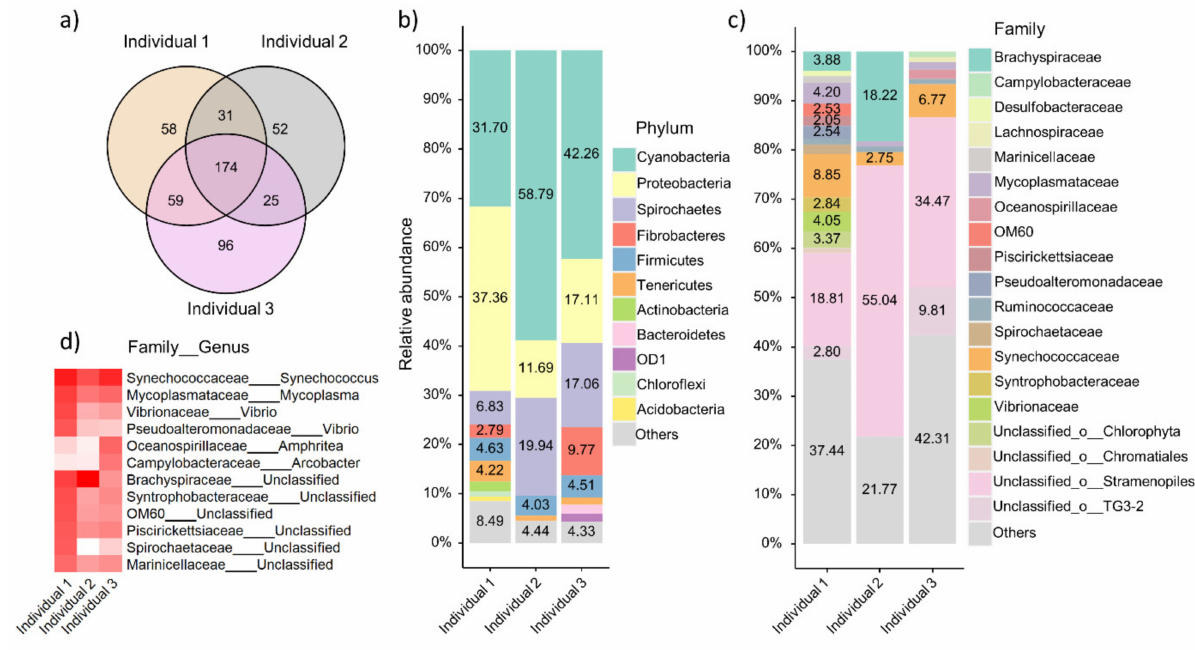
Figure 5. Gut microbiota diversity of three M. hongkongensis individuals. ( a ) Comparing OTUs identified in three oyster individuals; ( b , c ) phylum and family abundance of the common OTUs— only OTUs with an abundance over 1% are listed and abundance over 2% are labelled on chart; and ( d ) comparison on the abundance of common genera, white to red (low to high)—OTUs with an abundance over 1% in at least one